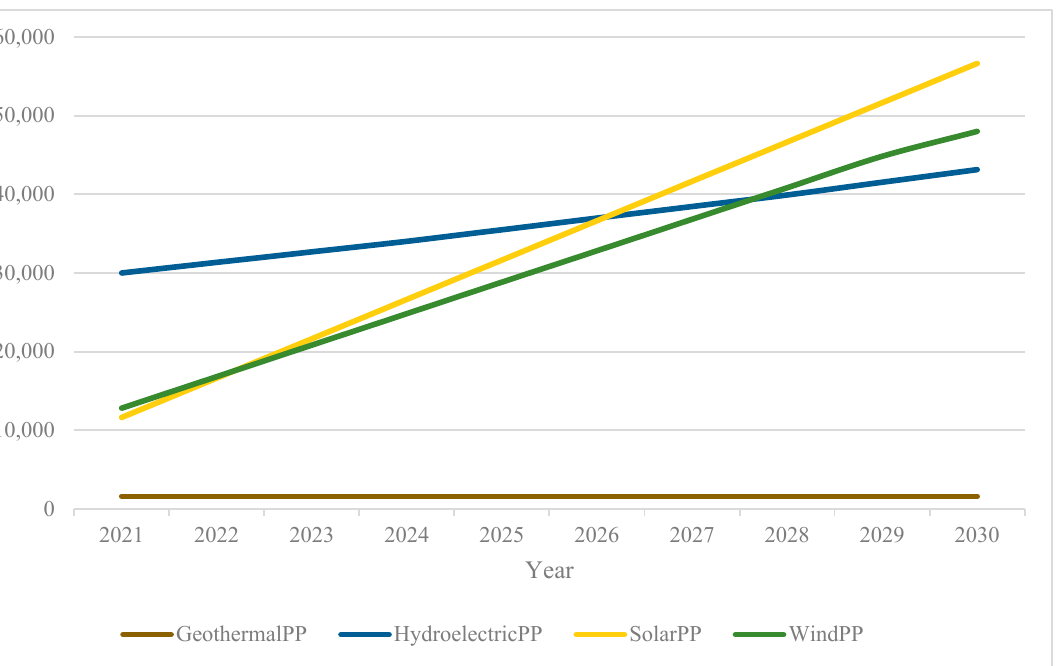
Figure 9. Installed capacities for the third scenario in the 2021–2040 horizon. 5. Conclusions This study examines Turkey’s strategic level electrical energy planning challenge from various perspectives, including the strategic plan, energy policy, capacity planning, and environmental policies of the government. To tackle the given problem, a mixed in- teger mathematical programming model that takes into account alternative power plant categories, such as fossil fuels, renewable energy, nuclear energy, and so on, is proposed. As several energy resources are included, the defined problem is characterized as a “gen- eral electricity planning problem”. In addition to lowering electricity generation costs, a variety of alternative policies, such as lowering CO 2 emissions, limiting energy resource